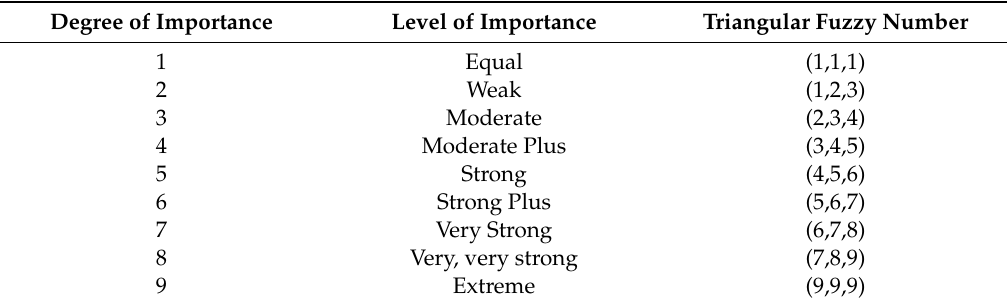
Table 3. Saaty’s Fuzzified Semantic Scale